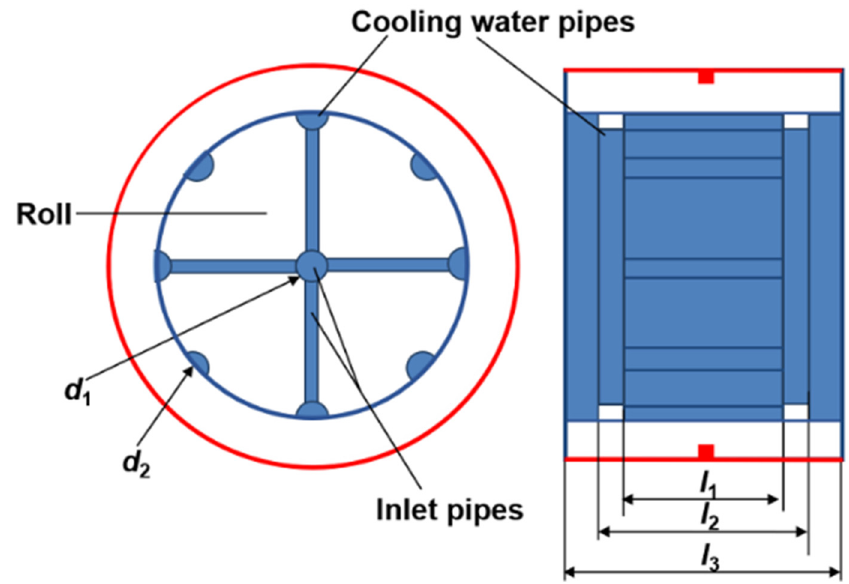
Figure 3. Distribution diagram of the cooling water system in the roll.